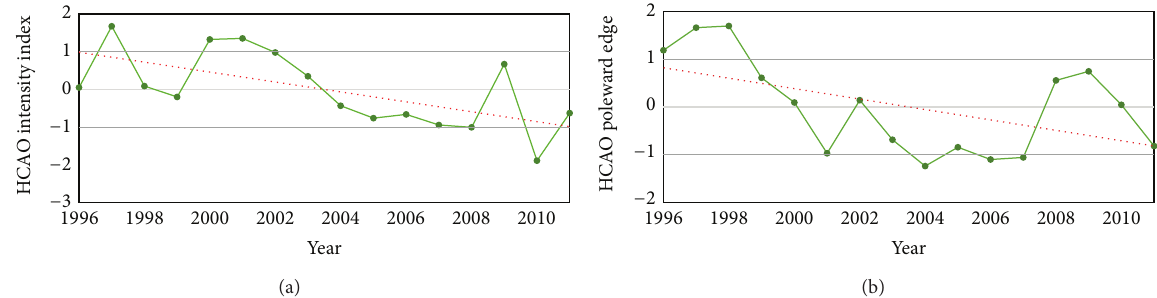
Figure 4: Normalized time series for the annual mean HCAO: (a) intensity index and (b) poleward edge in the period 1996–2011 with the linear trend (red dotted